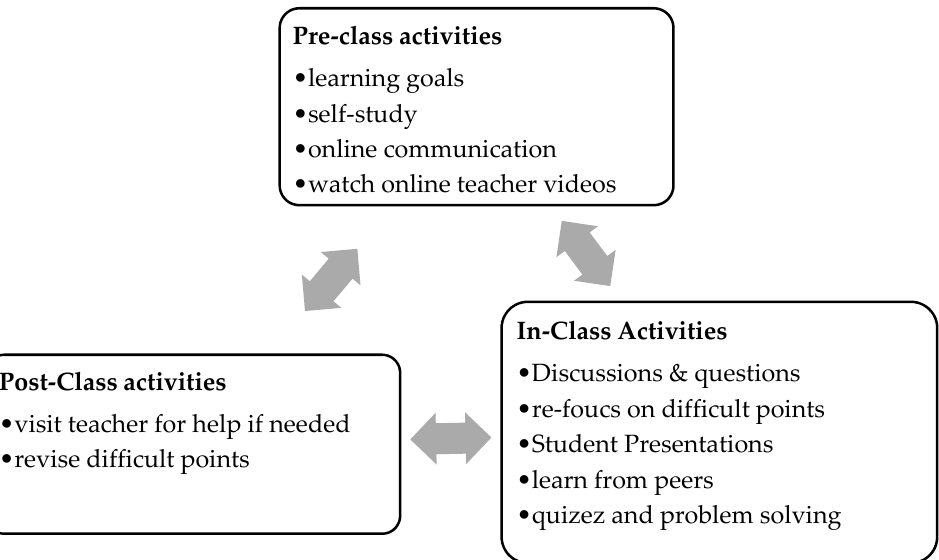
Figure 4. Adapted flowchart for the structure of flipped-classroom settings.